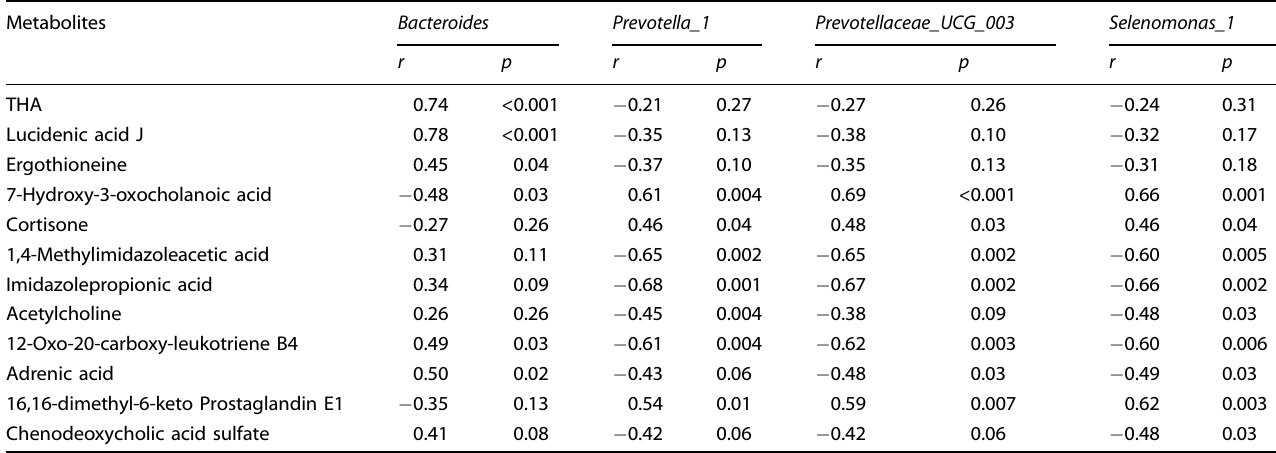
Table 2. Correlation analyses between the genera and abnormal